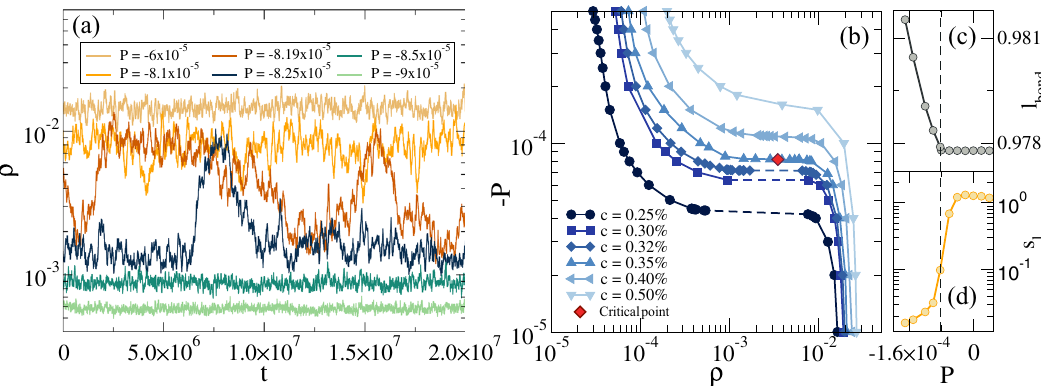
Fig. 4 Phase behavior and thermodynamics. ( a ) Density as a function of time for the Diam - 0.35% network at different negative pressures; ( b ) Equation of state of the diamond networks showing negative P as a function of ρ for different values of c . The red diamond symbol indicates the approximate location of the onset of mechanical instability and critical-like behavior. To improve visualization, data are shown using the opposite sign for (negative) pressure on a log-log scale; average values of (c) bond length l bond and (d) single-chain entropy s l as a function of P for the Diam - 0.35% network. The dashed line indicates the hyper-auxetic point ( P min = − 8.19 × 10 − 5 k B T / σ 3 ). Source data are provided as a Source Data fi Such an analogy is evident when looking at the density fl uctuations as a function of time for different pressures around P min for the Diam - 0.35% network that are shown in Fig. 4(a).